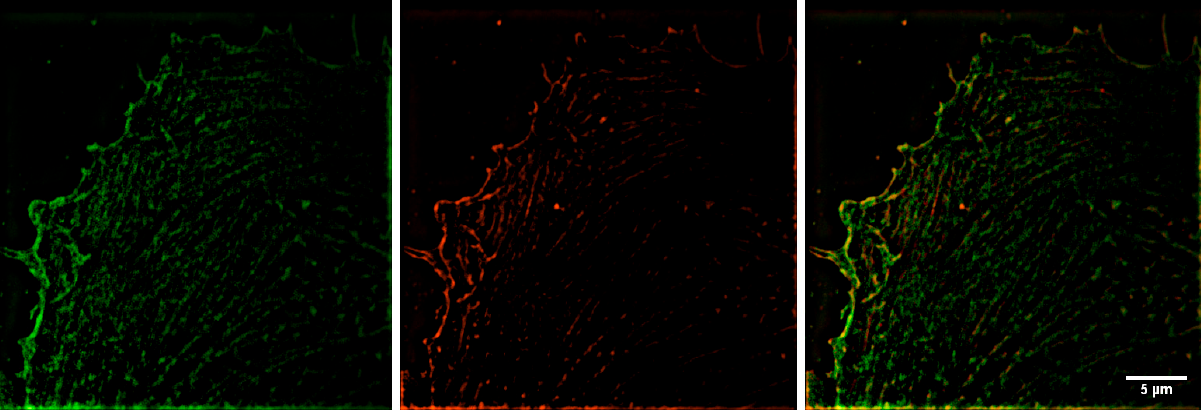
Figure 2. Immunofluorescent staining of β -(green) and γ -actin (red) in the basal region of HPAEC. In this optical section, β -actin apparently occupies a larger cell area than γ -actin.